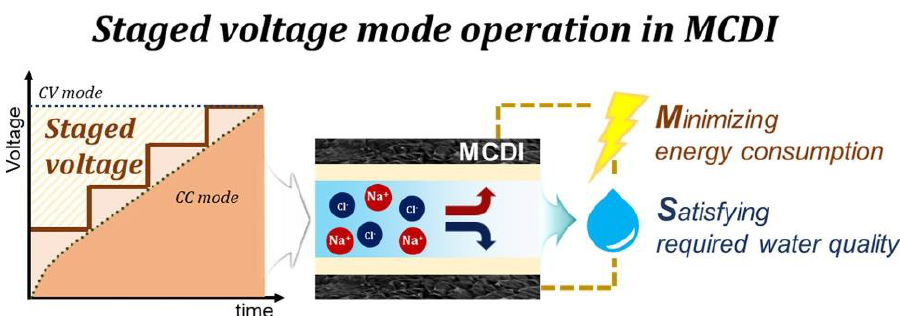
Figure 10. Schematic diagram of SV mode in MCDI [163]. Copyright 2020, Elsevier.